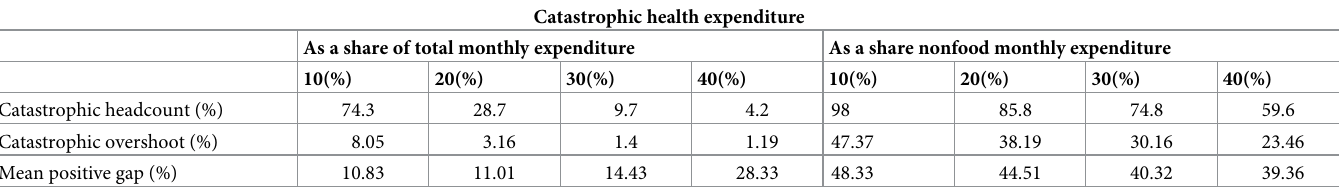
Table 4. Extent and intensity of catastrophic health expenditure at variable threshold levels of diabetic patients in public hospitals of Bahir Dar city administration, Ethiopia, 2019.